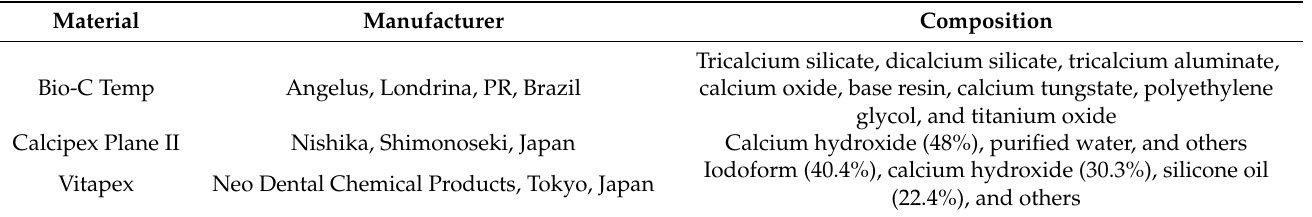
Table 1. Composition of the materials used in this